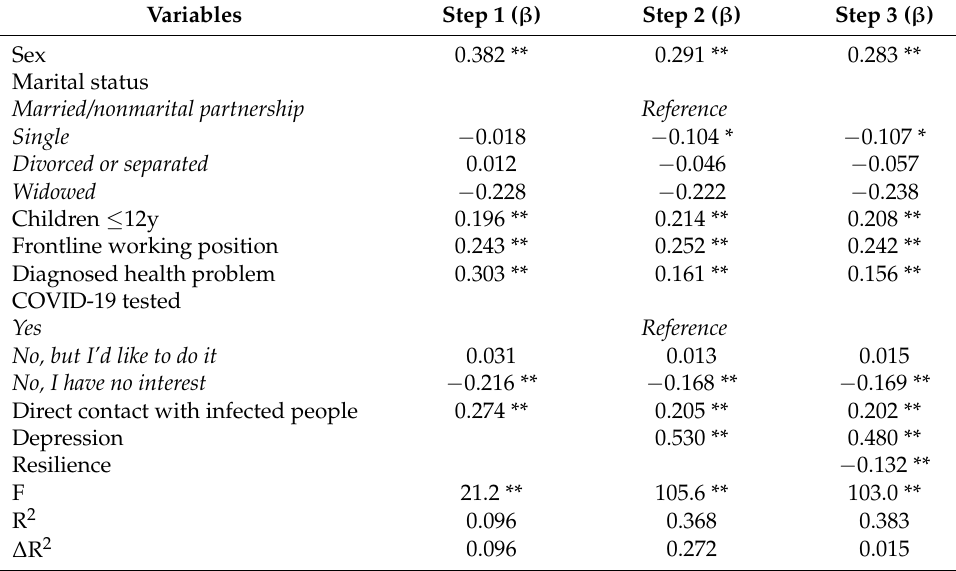
Table 2. Hierarchical linear regression analysis results (outcome variable: personal